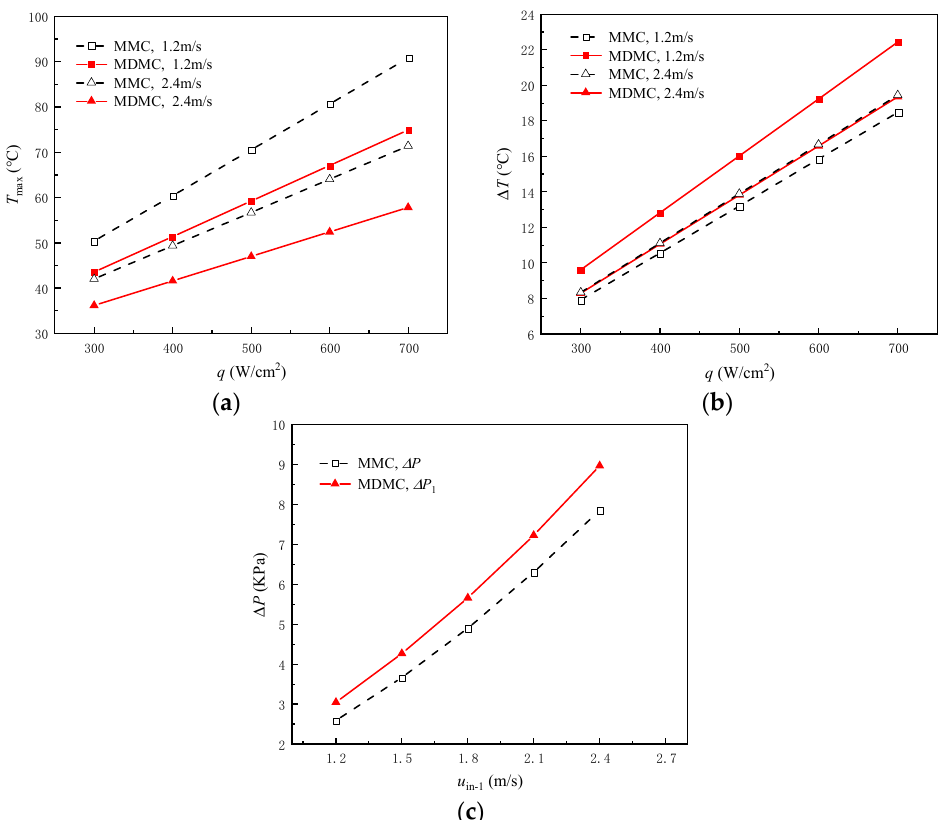
Figure 7. Comparison of heat transfer performance between MMC and MDMC structures. ( a ) T max ; ( b ) Δ T ; ( c ) Δ P .